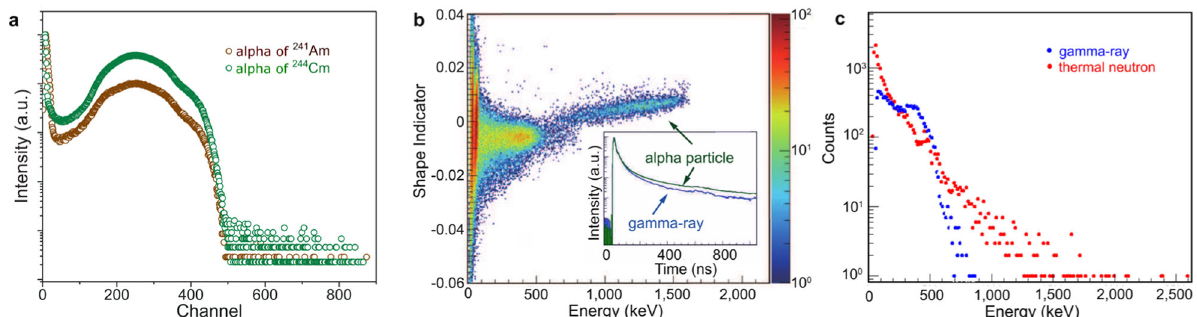
Fig. 5 Alpha particle detection and discrimination between thermal neutron and gamma ray. a Alpha particle pulse-height spectra. b Pulse-shape discrimination (PSD) matrix with the shape indicator on y -axis and the measured energy (electron equivalent) on x -axis. The inset with the green and the blue curves shows the normalized average waveforms from both alpha particle and gamma-ray radiation of 137 Cs and 241 Am sources, respectively. c Pulse- height spectra measured with graphite-moderated Am – Be neutron source of 1:1 Li-(PEA) 2 PbBr 4 crystal. The pulse-height spectra of neutron and 137 Cs sources are indicated by red and blue